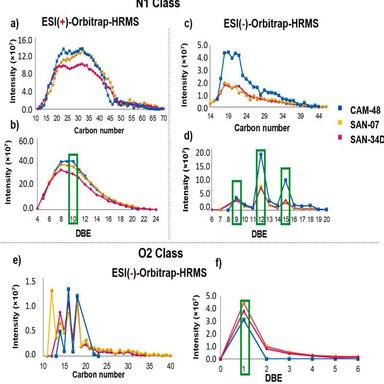
ESI(+)-Orbitrap-HRMS (a, b) and ESI(-)-Orbitrap-HRMS (c–f) graphics. Carbon number distributions (a, c, e) and DBE distributions (b, d, f) of the N1 and O2 classes for the three pre-salt oils.